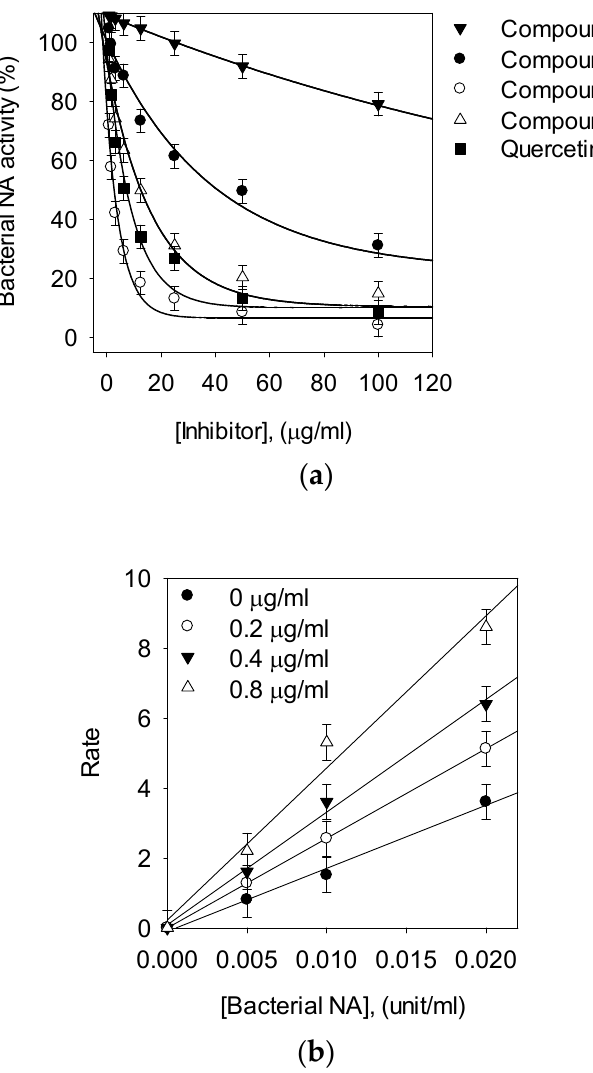
Figure 2. ( a ) Effects of compounds on bacterial neuraminidase (NA) catalyzed hydrolysis of 4- Figure 2. ( a ) E ff ects of compounds on bacterial neuraminidase (NA) catalyzed hydrolysis of methylumbelliferyl- N -acetyl-α- D -neuraminic acid sodium salt hydrate (MU-Neu5Ac) (compound 1 , 4-methylumbelliferyl- N -acetyl- α - d -neuraminic acid sodium salt hydrate (MU-Neu5Ac)